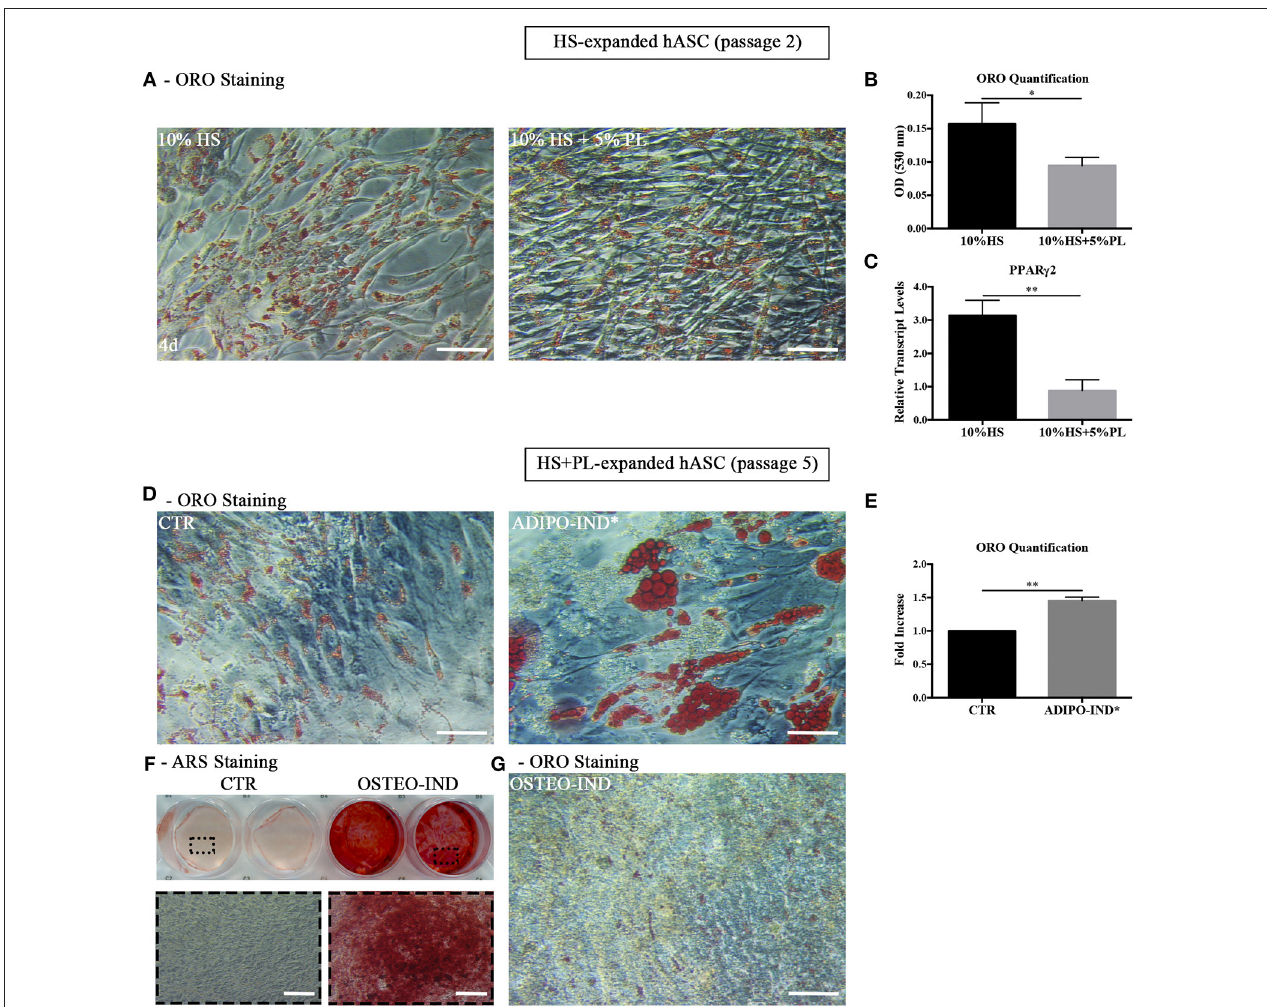
FIGURE 5 | (A,B) Differentiation potential of HS-expanded hASC after PL stimulation. (A) Representative ORO staining of PL-stimulated and un-stimulated cells at passage 2 after 4-day treatment (scale bars = 50 µ m); (B) Quantification by spectrophotometric analysis of ORO dye incorporated in PL-stimulated and un-stimulated hASC, normalized to the cell number ratio between HS and HS + PL. Average values ± SD of 4 independent experiments, each one performed in triplicate and corresponding to 3 different hASC cultures, are reported. The * symbol refers to p = 0.01; (C) Real Time quantitative PCR analysis of PPAR γ 2 transcript level in cells treated or not treated with PL for 4 days. Results are expressed as means ± SD values of 3 independent experiments assayed in triplicate. The ** symbol refers to p = 0.002; (D–F) HS-expanded hASC cultured in the presence of 5% PL for additional 3 passages were induced toward adipogenesis and osteogenesis. (D) Control and adipogenesis induced cells ORO staining (scale bars = 50 µ m); (E) Quantification by spectrophotometric analysis of ORO dye incorporated in adipogenesis-induced and control (CTR) cells. Results are expressed as ratio referred to CTR value. Average values ± SD of 2 independent experiments, each one performed in triplicate, are reported. The ** symbol corresponds to p = 0.008; (F) Representative ARS staining of osteogenesis-induced and control cells. Lower images are magnifications of highlighted areas (scale bars = 200 µ m); (G) Representative ORO staining of osteogenesis-induced cells (scale bars = 50 µ